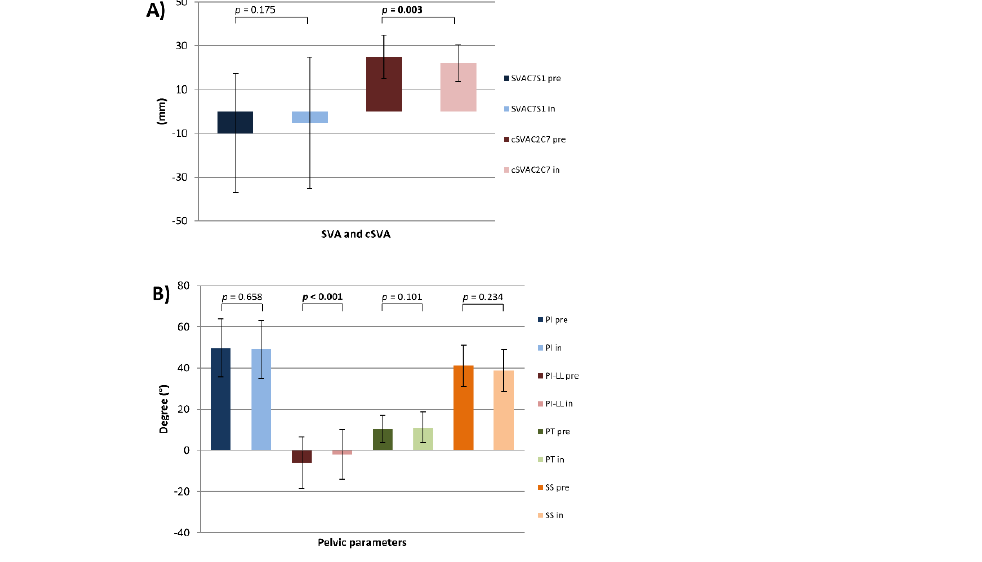
Figure 5. Sagittal plane parameters. ( A ) SVA, cSVA and ( B ) pelvic parameters for all patients (pre- and in-brace); p = statistical significance, p < 0.05.